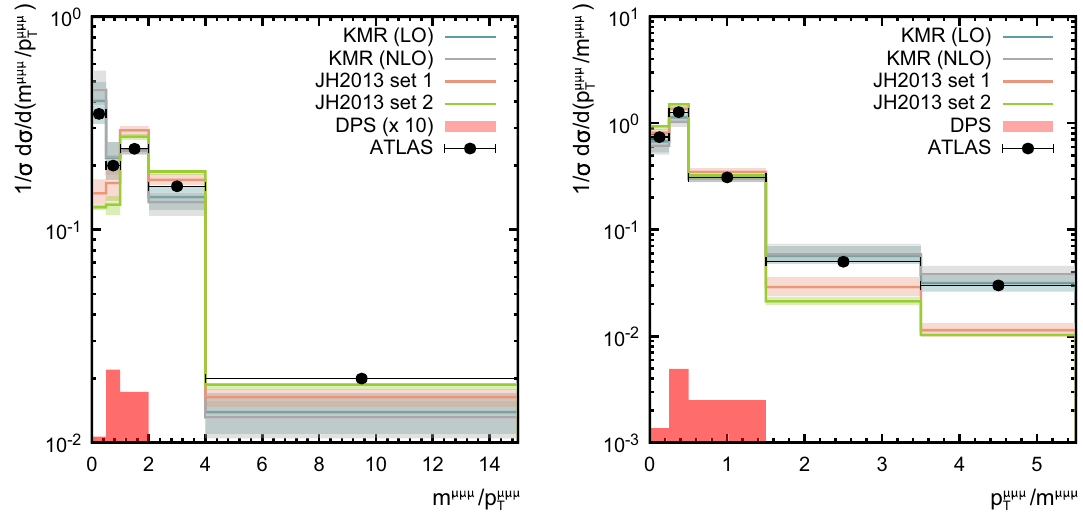
√ s = 8 TeV as a function of m μμμ / p